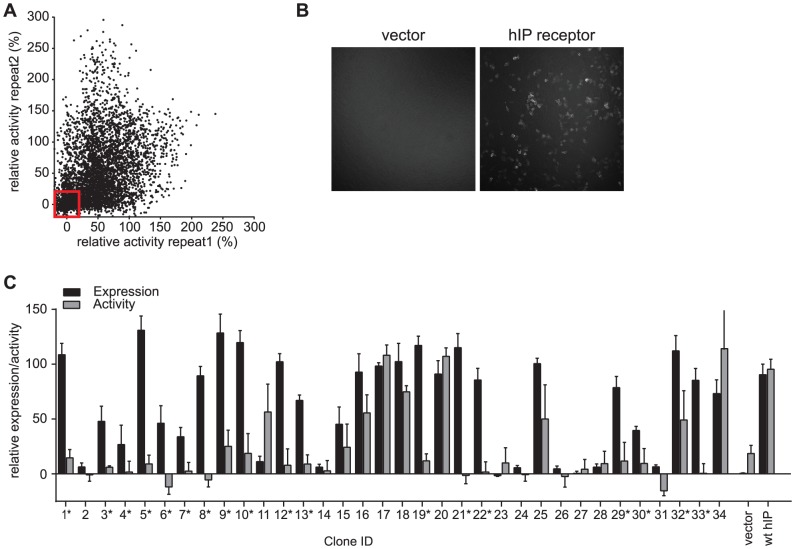
Error-prone PCR mediated mutagenesis of hIP receptor identified 32 mutants with reduced activity.(A) Scatter blot showing activity data of the hIP receptor library in the primary screen. Cells stably expressing the GloSensor cAMP plasmid were transfected with our hIP receptor constructs and stimulated with 1 µM MRE-269. The luminescent signal was normalized to the signal obtained in hIP receptor wild-type transfected cells. The experiment was performed in duplicates, shown on separate axis. Red box indicates clones with <25% activity as compared to wild-type hIP receptor. (B) Exemplary images of vector or hIP receptor expressing cells, stained with Alexa-647 anti HA-antibody. (C) Bar chart showing the relative expression level (as assessed by staining with Alexa-647 anti-HA-antibody) and the relative activity (as assessed by GloSensor cAMP assay) for 34 selected constructs. Asterisk indicates mutants classified as hits. Data were normalized to hIP receptor wild-type expressing cells and represents the mean ± SEM of three independent experiments.